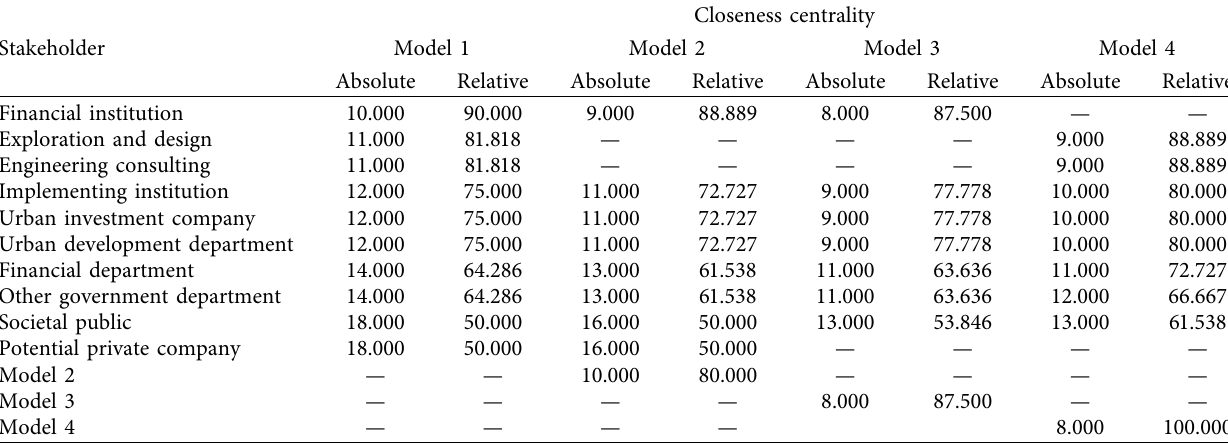
Table 10: Index of closeness